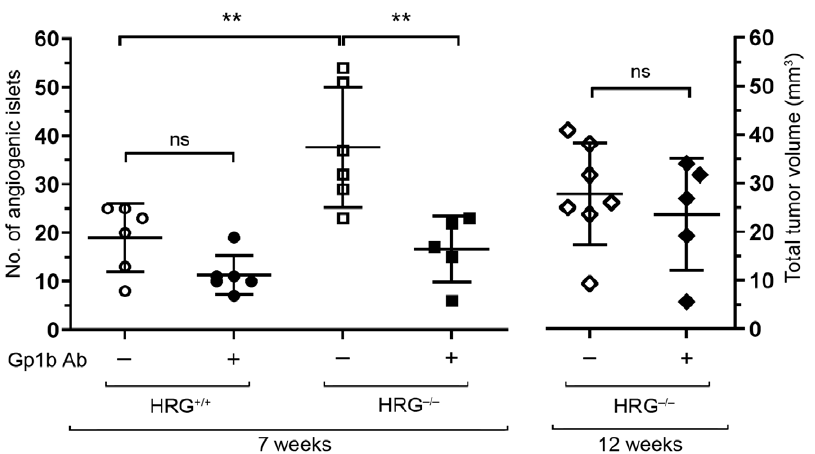
Figure 6. Platelet depletion suppresses the increased angiogenic switch in RT2/HRG + / + mice. RT2/HRG + / + and RT2/HRG 2 / 2 mice (n=6/ group) were rendered thrombocytopenic by treatment with an anti-GP1b a antibody during two weeks before the onset of the angiogenic switch. At 7 weeks of age angiogenic islets were counted in each animal. A second group of RT2/HRG 2 / 2 mice were treated with the anti-GP1b a antibody during two weeks after the angiogenic switch and tumor volumes analyzed at 12 weeks of age (n=6/group). (Data on untreated animals at 7 weeks were originally published in [3].) Statistical analyses were performed with a two-tailed Mann-Whitney test, vertical bars represent standard deviation, ** p # 0.001, ns=non